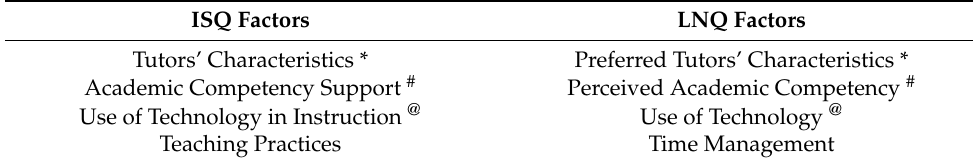
Table 9. Factors from the ISQ and